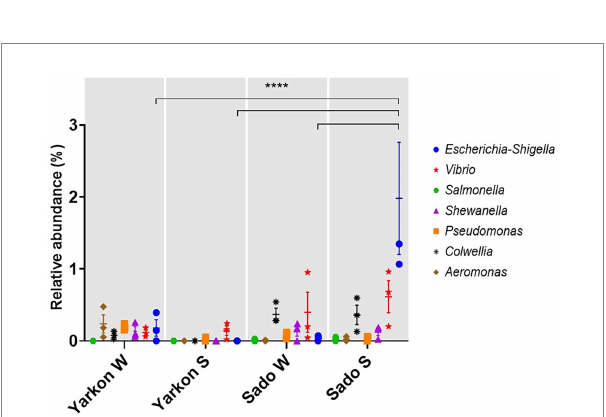
FIGURE 8 Relative abundances of potentially pathogenic genera in the microplastic samples from Yarkon and Sado in winter (W) and summer (S). Significance was assessed using 2-way ANOVA. N = 3. p =